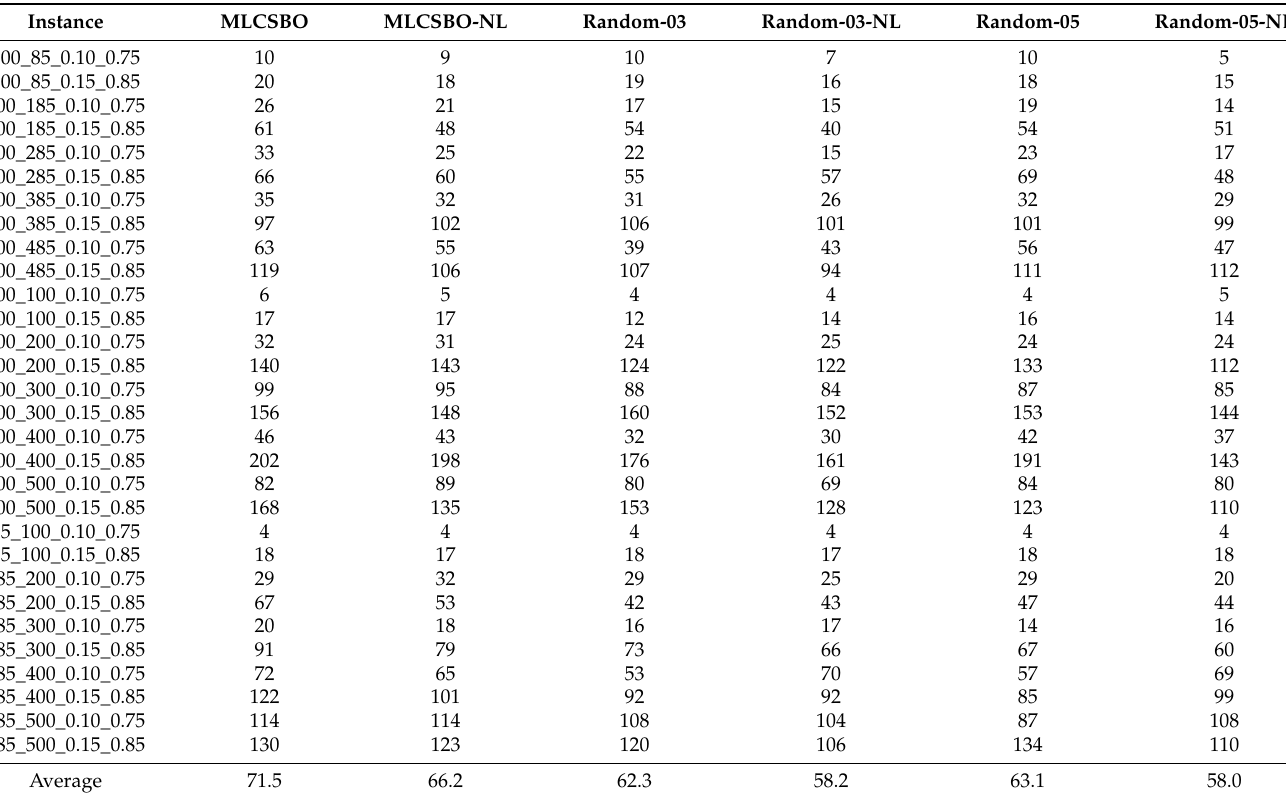
Table 3. Average runtime values in seconds for MLCSBO and random operators, with and without a local search operator. Instance